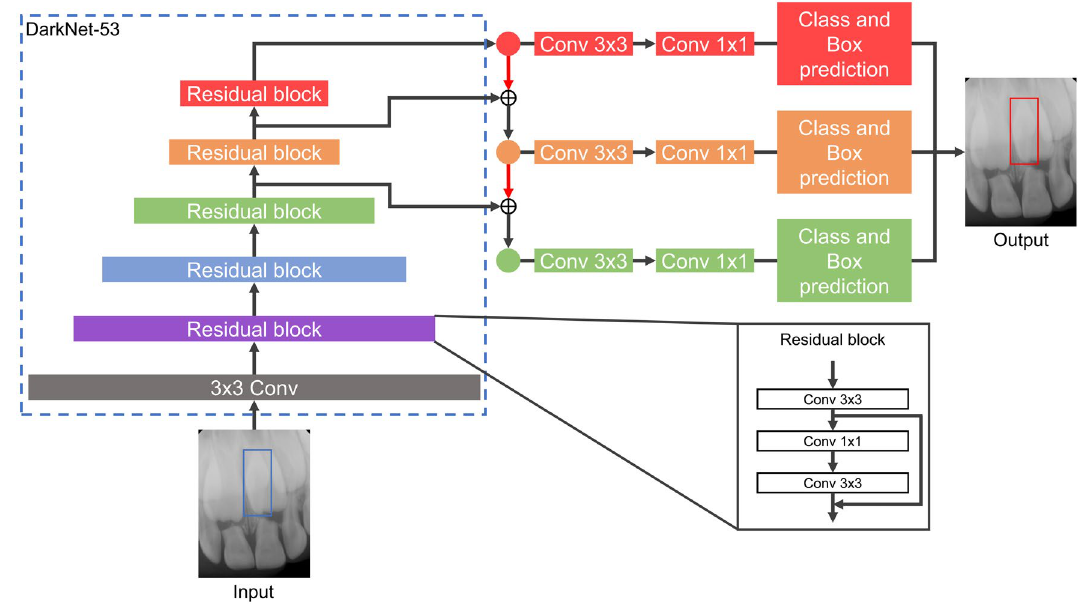
Figure 1. The structure of the YOLOv3 algorithm. Conv convolutional layer.